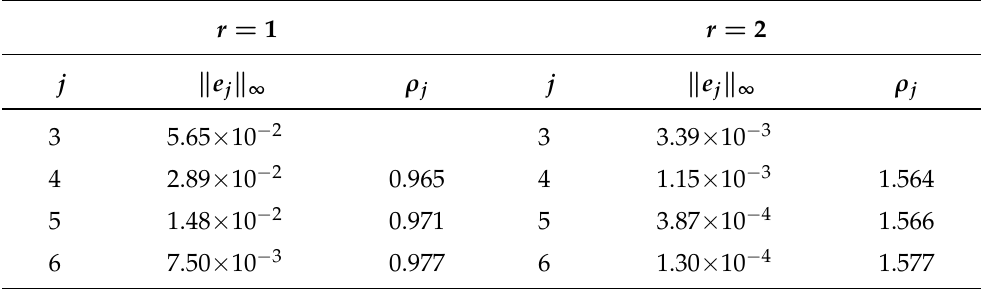
Table 6. Bagley–Torvik equation: the infinity norm of the error and the numerical convergence order when using dQ nj y with r = 1 (left) and r = 2